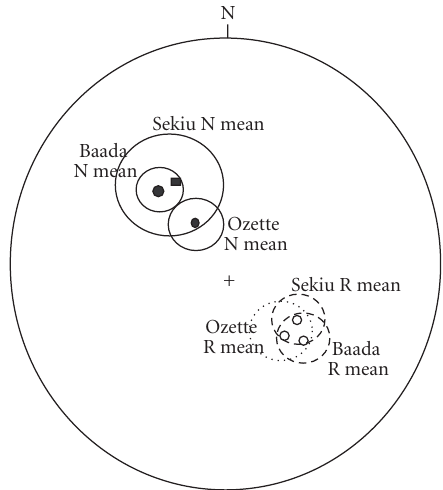
Figure 5: Equal area projections of estimated means directions of sites in the Makah Formation. Solid dots, rectangles, and solid circles indicate mean for normal polarity sites (lower hemisphere projection). Open dots and dashed lines indicate mean of reverse polarity samples (upper hemisphere projection). As can be seen from the plot, the directions are antipodal, suggesting that the primary remanence has been obtained and most overprinting has been removed. “Baada N mean” and “Baada R mean” refer to the means of normal and reversed sites from the Baada Point section; “Ozette N mean” and “Ozette R mean” are from the Ozette Road- Hoko River section; and “Sekiu N mean;” “Sekiu R mean” are from the coastal section between Shipwreck Point and the mouth of the Sekiu